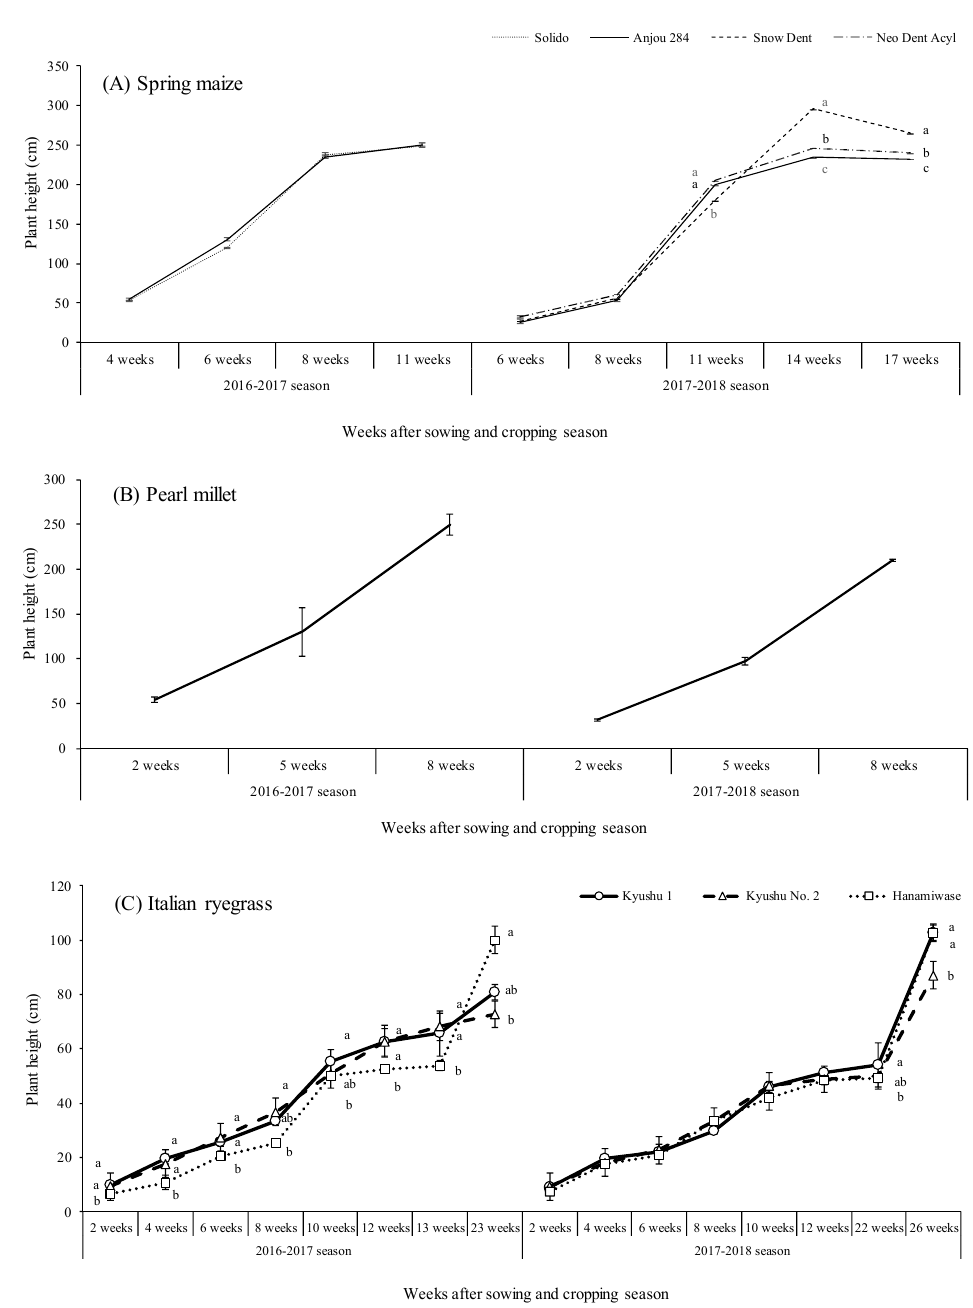
Figure 2. Changes in plant height in spring maize ( A ), pearl millet ( B ) and twice-cut Italian ryegrass ( C ) in two cropping seasons. Values show mean ± standard error ( n = 3). a–c p < 0.05 among cultivars in the same cropping season and system.